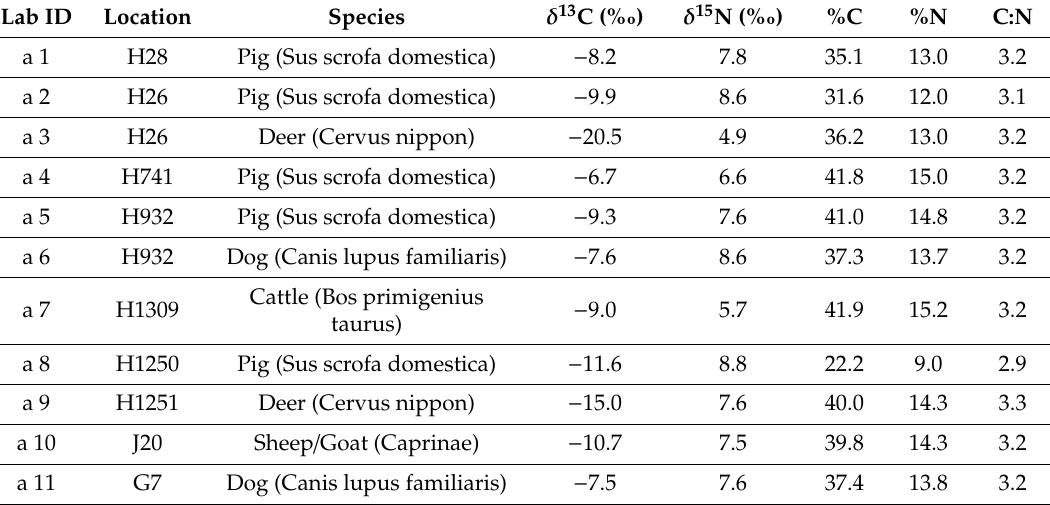
Table 3. Isotopic results and sample information for all fauna from the Guandimiao site, Henan Province,